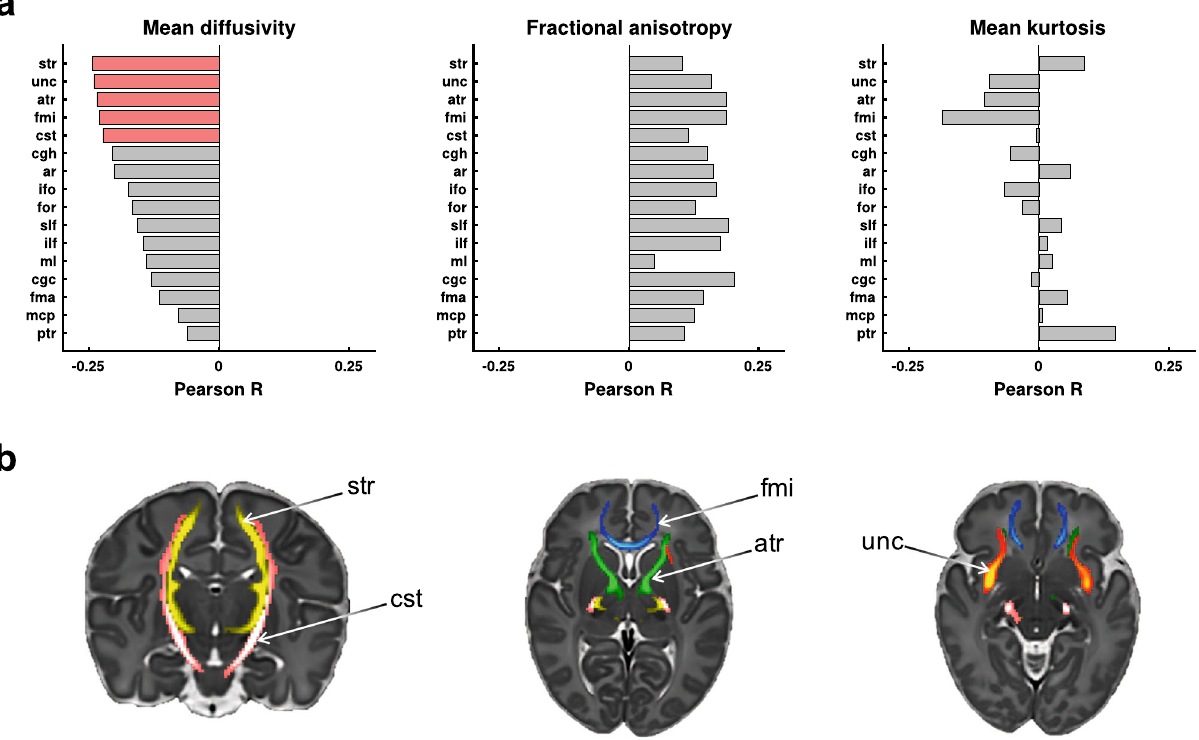
Fig. 5 Exploration of structure-function associations in the dHCP dataset. The structural feature per white matter tract is the voxelwise mean diffusion parameter: mean diffusivity, fractional anisotropy, and mean kurtosis. The functional feature is the predicted noxious-evoked response amplitude, generated using the resting-state prediction model. a The three plots display the Pearson correlation coef fi cients ( x -axis) between response amplitudes and diffusion parameters for all 16 white matter tracts ( y -axis). The white matter tracts are ordered according to the mean diffusivity correlation coef fi cients for which statistically signi fi cant results were found (red). Statistical signi fi cance is FWER-corrected for multiple testing across all 48 Pearson correlation tests. b Maps displaying the fi ve bilateral white matter tracts statistically signi fi cantly related to predicted noxious-evoked response amplitudes. ar acoustic radiation, atr anterior thalamic radiation, cgc cingulate gyrus part of the cingulum, cgh parahippocampal part of the cingulum, cst corticospinal tract, fma forceps major, fmi forceps minor, for fornix, ifo inferior fronto-occipital fasciculus, ilf inferior longitudinal fasciculus, mcp middle cerebellar peduncle, ml medial lemniscus, ptr posterior thalamic radiation, slf superior longitudinal fasciculus, str superior thalamic radiation, unc uncinate fasciculus. Source data are provided as a Source Data fi